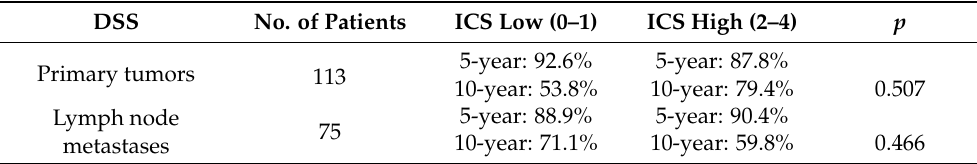
Table 2. Disease-specific survival (DSS) rates based on immune cell score (ICS) in primary small bowel neuroendocrine tumors and lymph node metastases. DSS